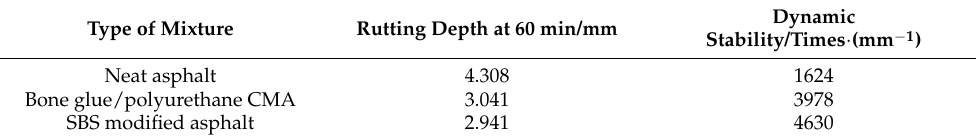
Table 10. Wheel tracking test results.